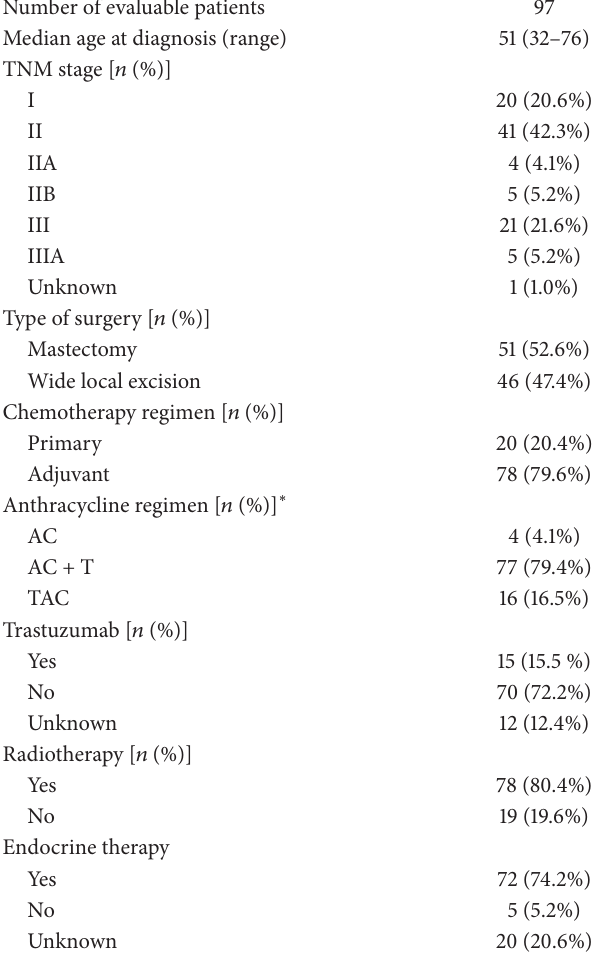
Table 1: Baseline demographic